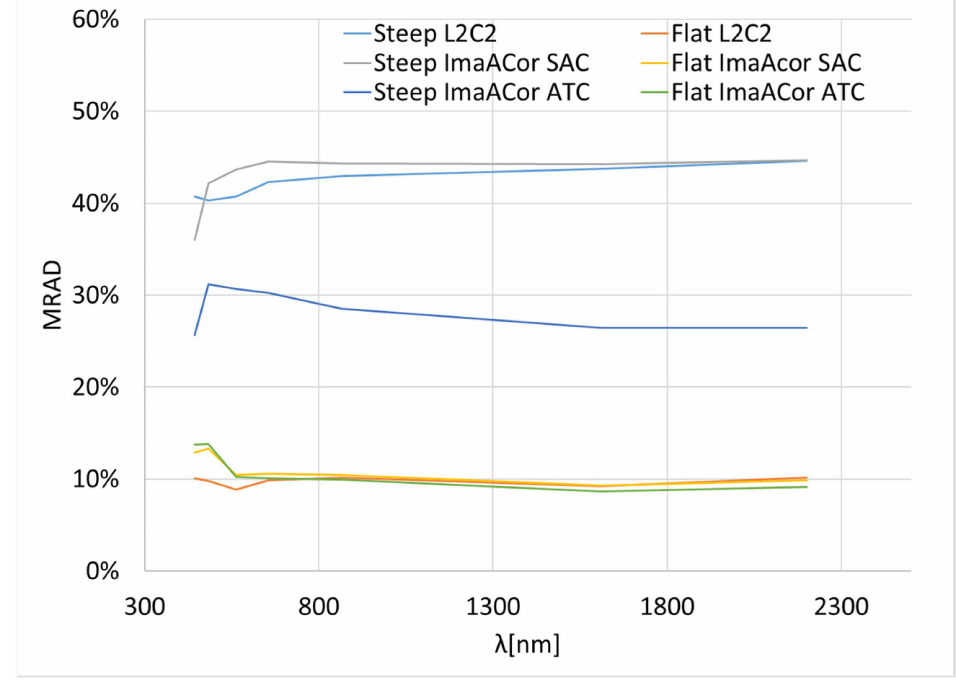
Figure 7. MRAD plots, as a function of wavelength, of the L2C2 Landsat 8 reflectances and ImaACor SAC and ATC reflectances obtained from L1 Landsat-8 data, for flat and steep